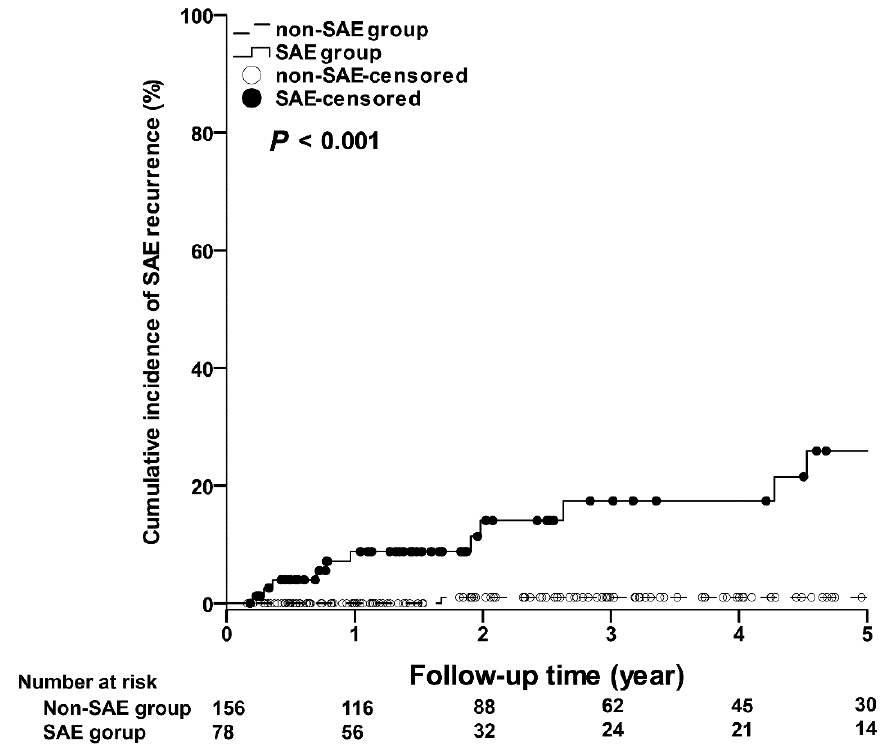
Figure 3. The cumulative incidences of severe acute exacerbation recurrence. SAE, severe acute exacerbation.